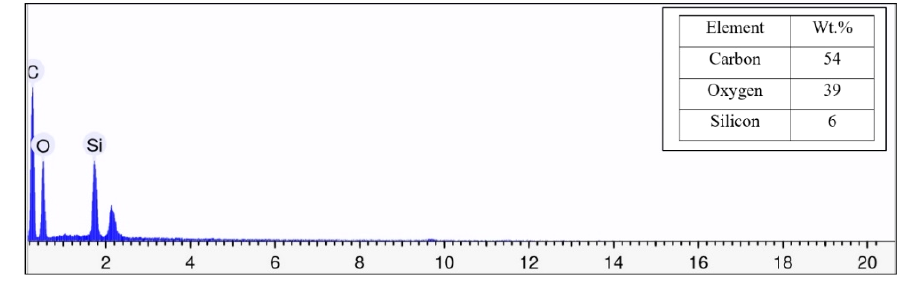
Figure 6. EDX spectrum of the coated polyester fabric